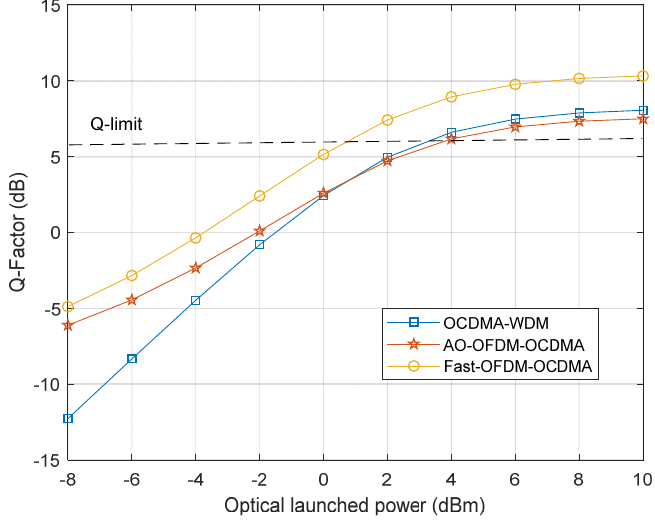
Figure 5. Q-factor versus launched optical power.